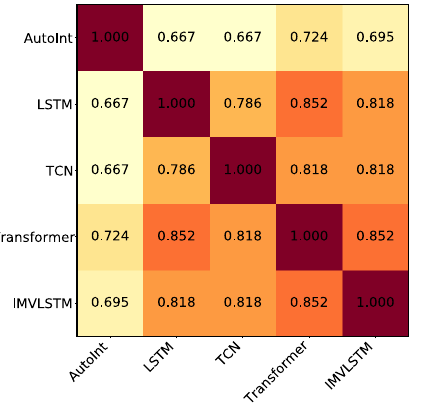
Figure 2. Jaccard similarity of top-50 most important features identified in all